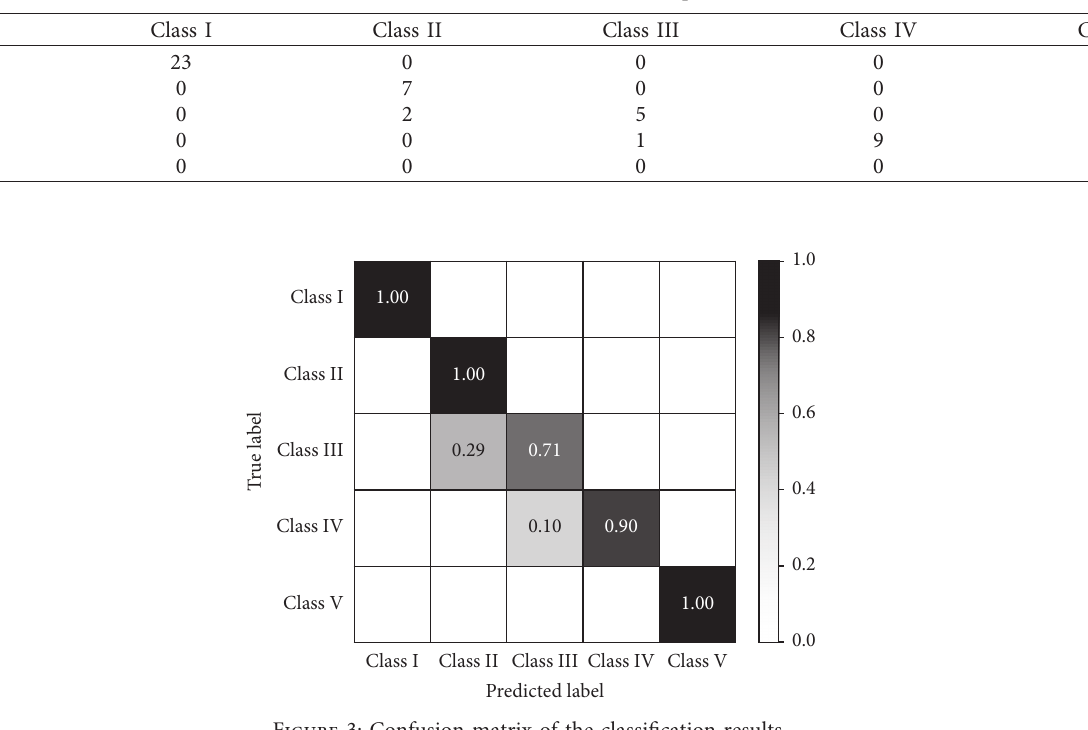
Table 5: Classification result of the experts.